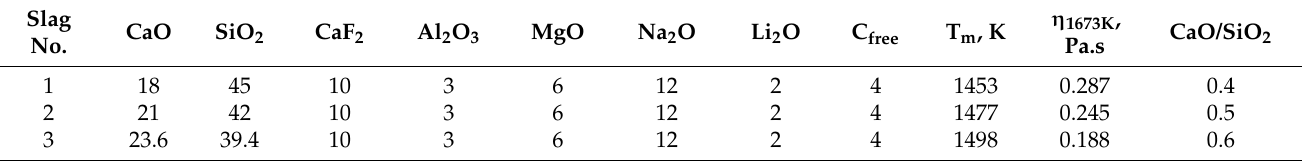
Table 2. Composition (wt%) and physical properties of initial refining